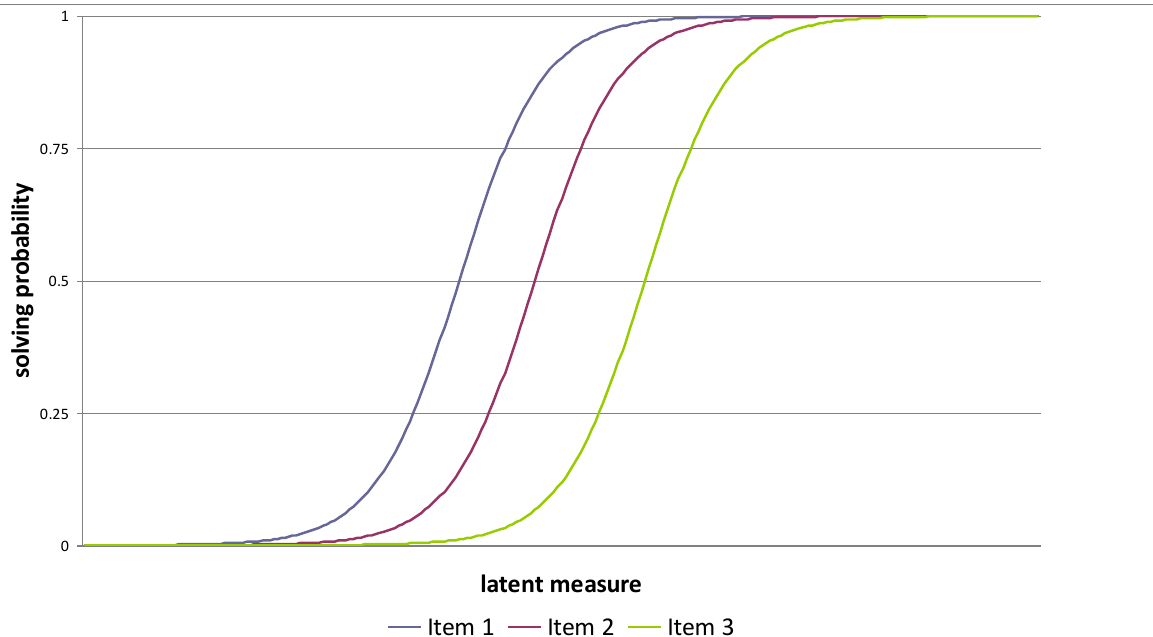
Figure 1. Rasch item function curves for three items with different